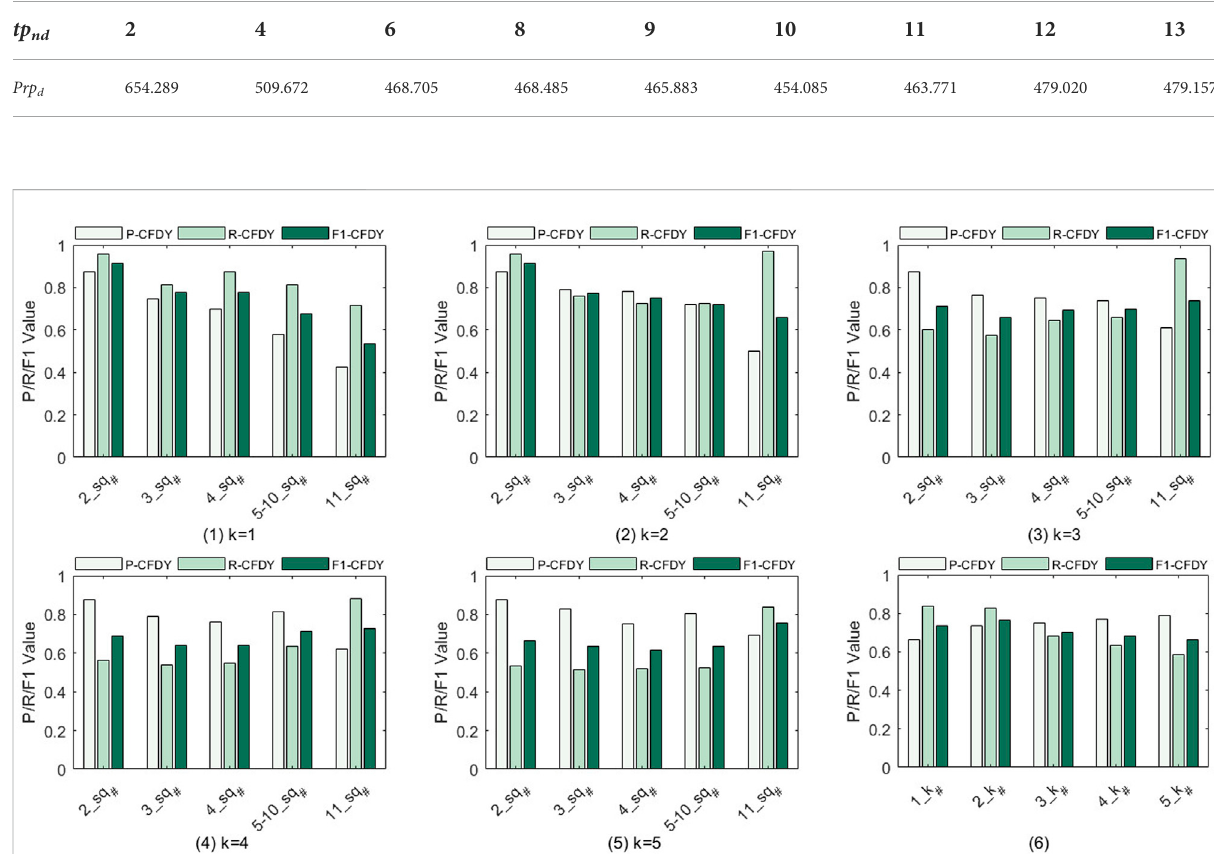
FIGURE 2 Precision, recall, and F1 value for the fragment discovery when k # is set to 1, 2, 3, 4, and 5,